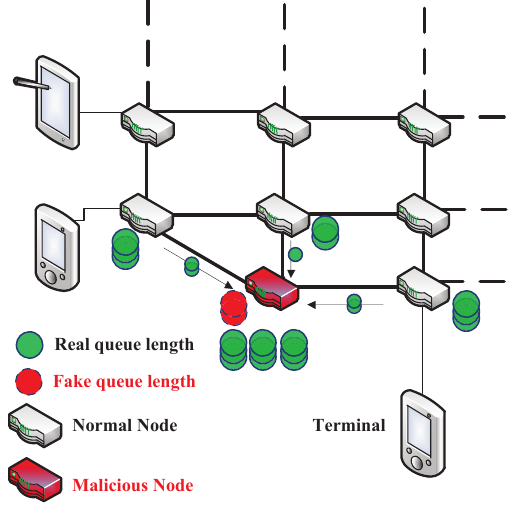
Figure 1. The malicious node in a backpressure (BP) routing